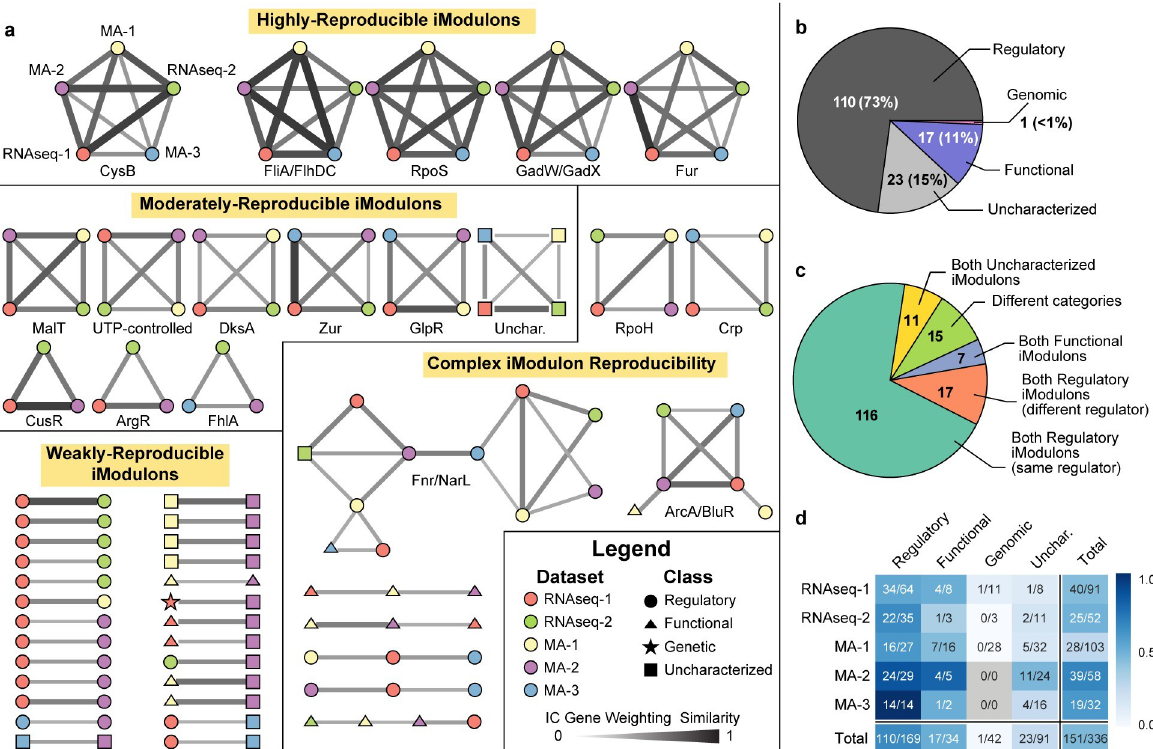
Fig 3. The iModulon structure is conserved across five datasets. (A) Reciprocal best hit (RBH) graph indicating iModulons as nodes and RBHs as edges. Node color indicates the source dataset for the iModulon, as denoted for the CysB iModulon. Node shape indicates the iModulon category. Edge thickness and darkness indicate the gene weighting similarity. Clusters are labelled with the regulator(s) that are linked to the iModulons in the cluster, if available, and grouped by level of iModulon reproducibility. (B) Pie chart describing the categories of all iModulons shown in the RBH graph. (C) Pie chart describing the types of edges in the RBH graph. (D) Heatmap indicating how many iModulons from each dataset and category were in the RBH graph.